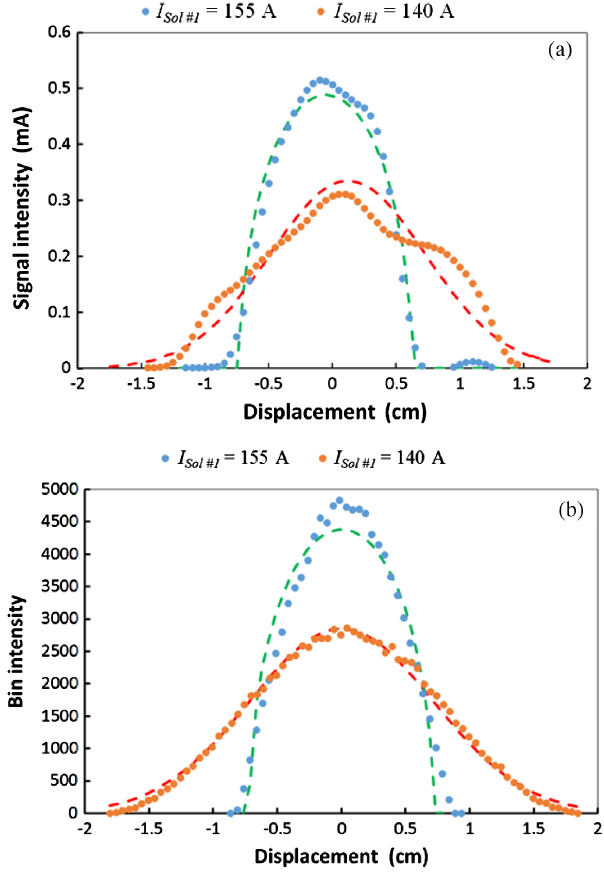
FIG. 11. 1D beam profiles at the scrapers. (a) Data; (b) T RACE- W IN simulations. Dashed curves are fits, assuming a uniform (green) or a Gaussian (red)